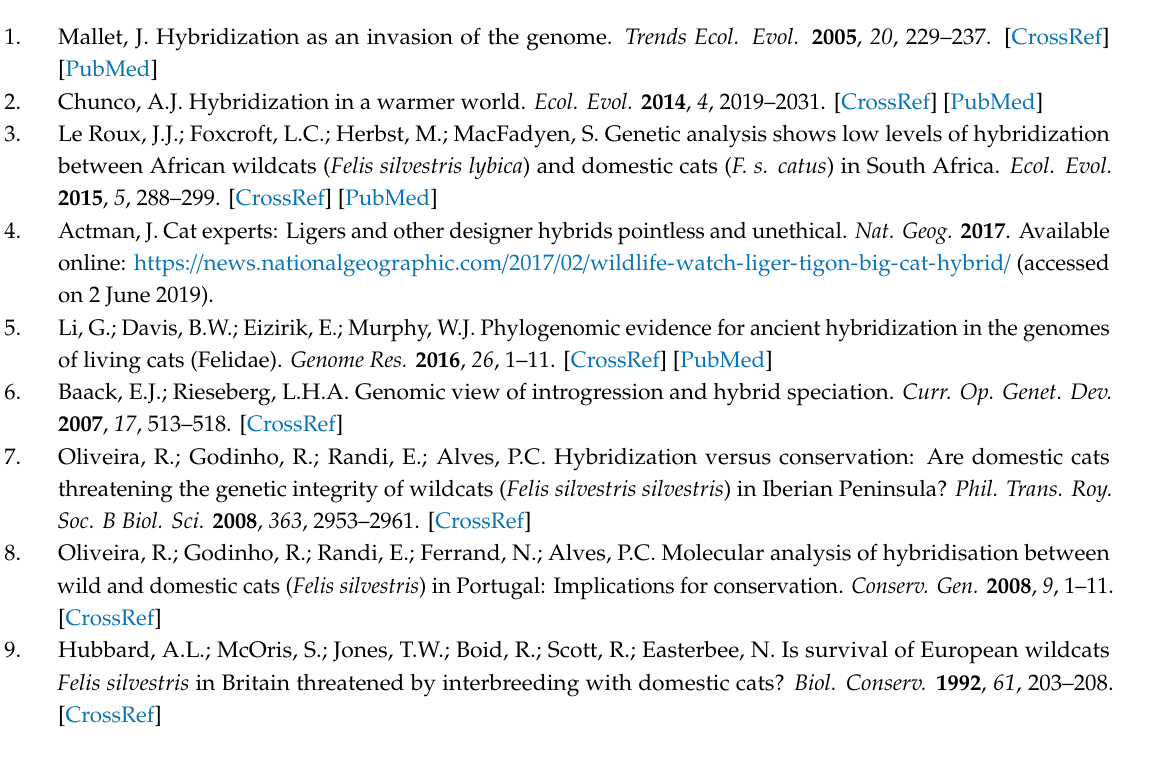
Table S1: Australian terrestrial mammal species assessed as more susceptible to predation from savannah cats than domestic